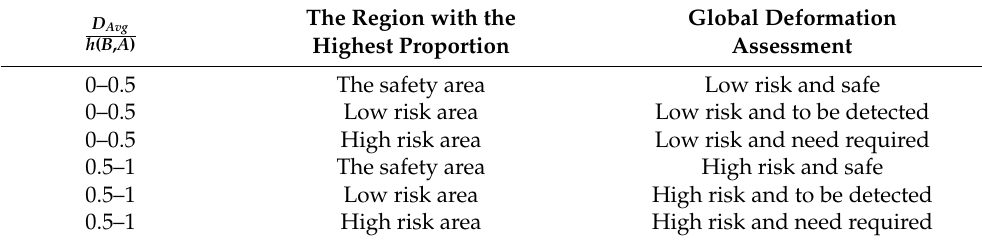
Table 1. Evaluation standard for integral deformation of tower